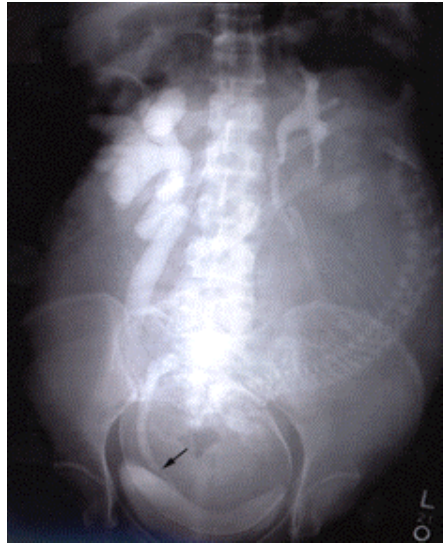
FIGURE 1 . Intravenous pyelogram at term showing a filling defect at the right ureterovesical junction (arrow), consistent with the distal ureteral